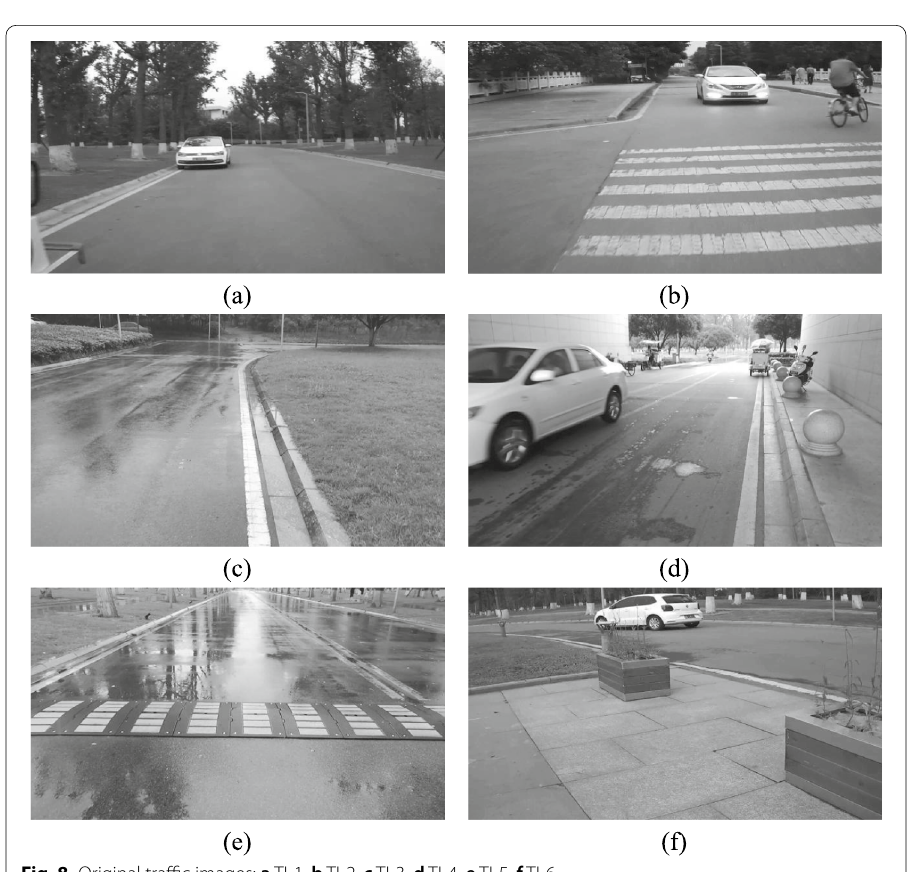
Fig. 8 Original traffic images: a TI-1, b TI-2, c TI-3, d TI-4, e TI-5, f